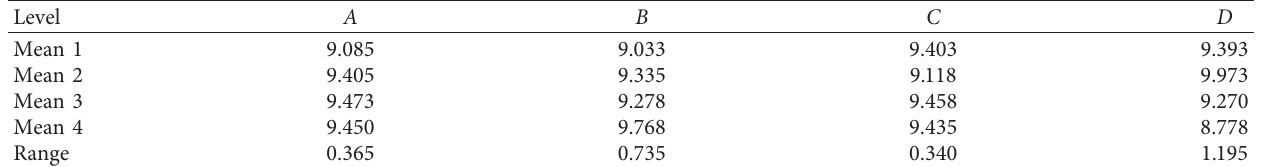
Table 4: Range analysis table of maximum thinning